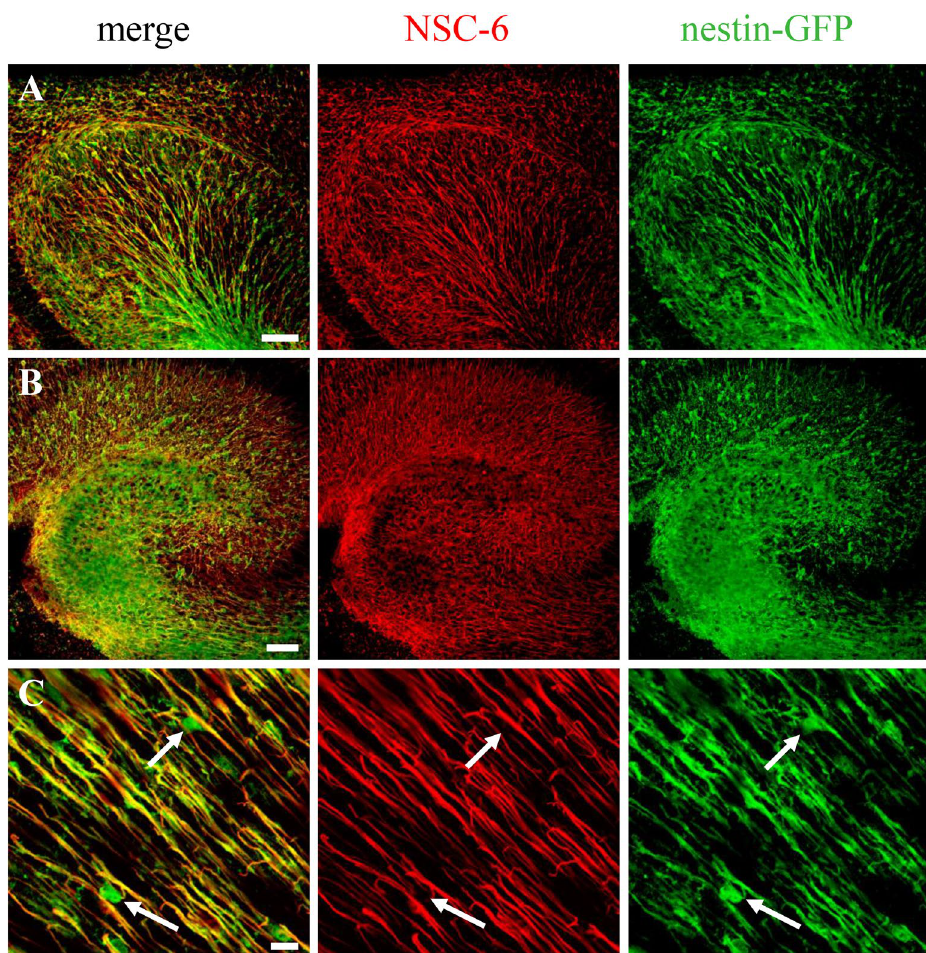
Figure 2. NSC-6 antibody immunolabels radial glia in the embryonic mouse brain. NSC-6 immunolabeling (red) is present along the processes of radial glia in Nestin -GFP embryonic (E12) cortex ( A ) and hippocampus ( B ). ( C ) High magnification image of the embryonic cortex shows Nestin -GFP expression in the nucleus and soma of radial glia (arrows). These compartments were not immunolabeled by the NSC-6 Ab. Scale bars are 50 µm in ( A , B ); and 5 µm in ( C